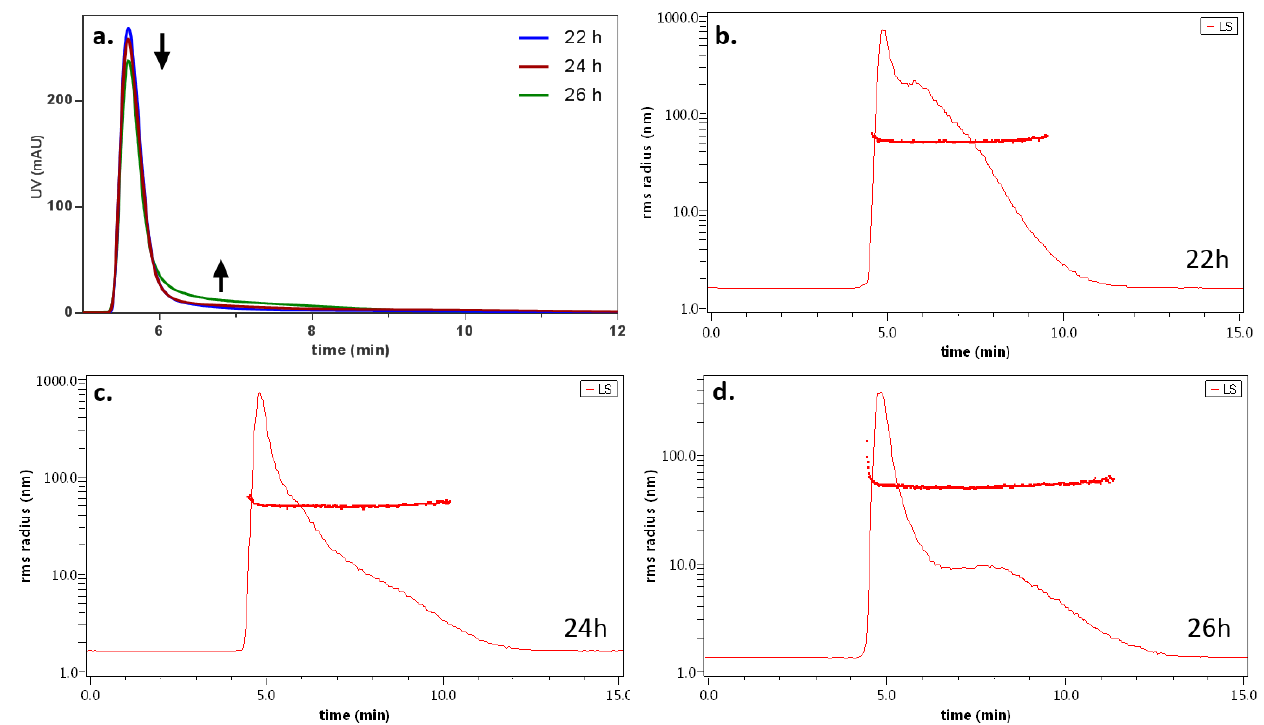
Figure 2. ( a ) Overlay of the UV absorption signal at 310 nm at three timepoints (22, 24, and 26 h). ( b – d ) LS signal (at 90°) and calculated radius of the species detected at the three timepoints. ( b – d ) LS signal (at 90 ◦ ) and calculated radius of the species detected at the three